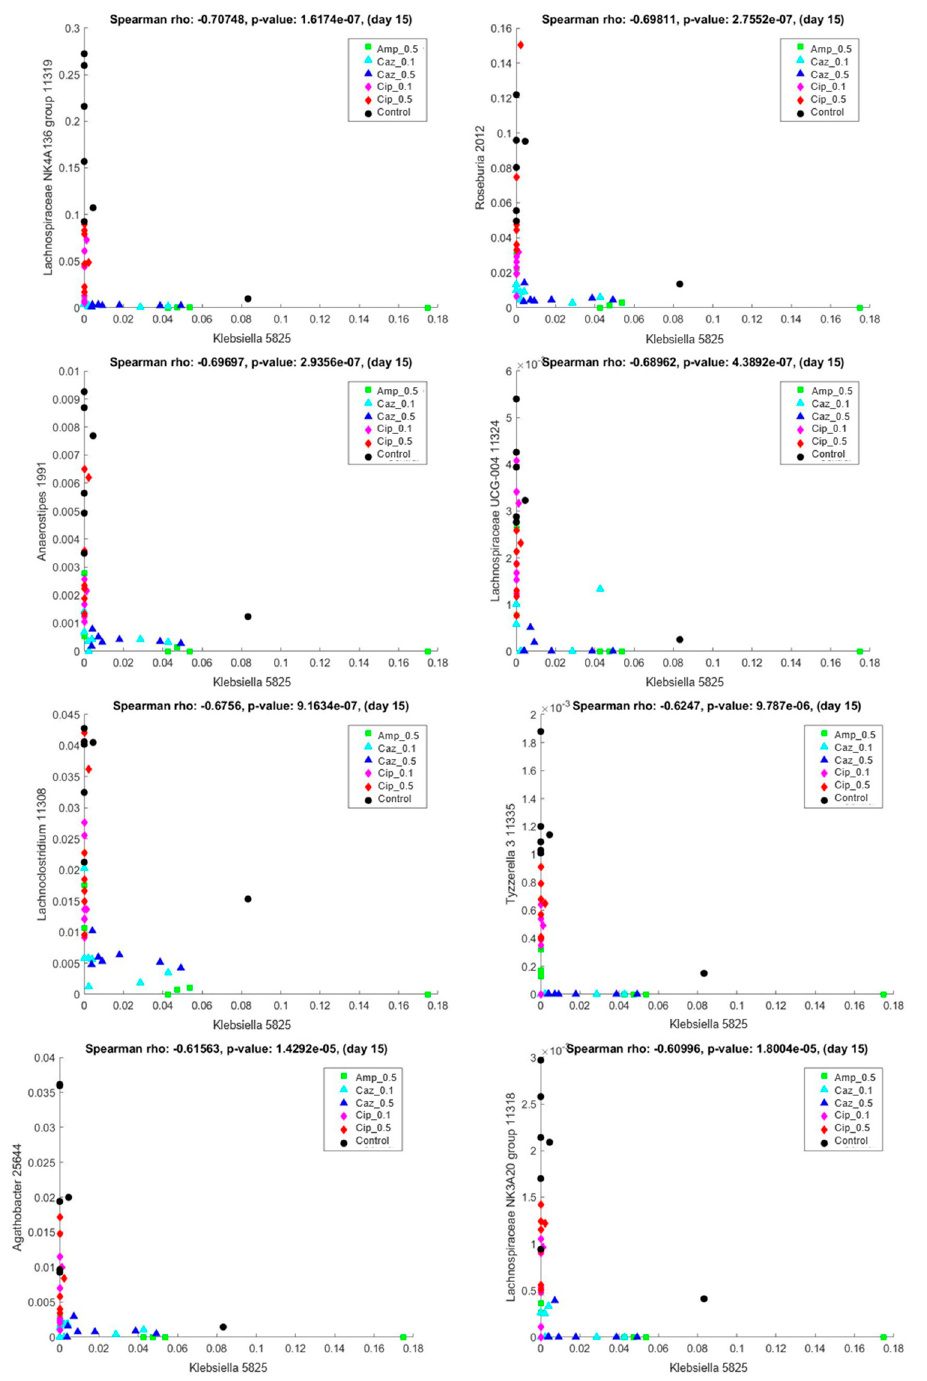
Figure 7. Correlation between Klebsiella KP5825 (x-axis) and other bacterial genera in samples of day 15. Lachnospiraceae NK4A136 group 11319, Roseburia 2012, Anaerostipes 1991, Lachnospiraceae UCG- 004 11324, Lachnoclostridium 11308, Tyzzerella 11335, Agathobacter 25664, and Lachnospiraceae NK3A20 group 11318